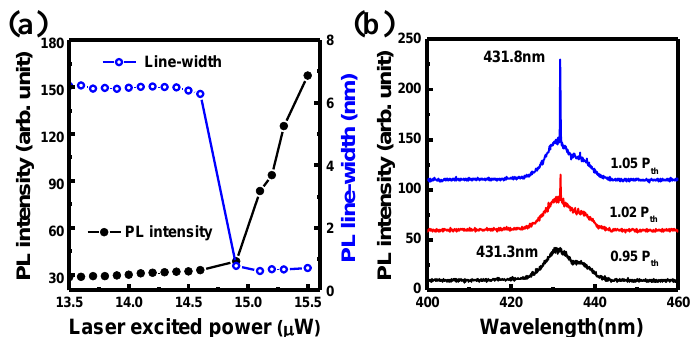
Figure 4. ( a ) The PL intensities and the linewidth of the optical pumping spectra were measured as a function of the laser excited power. ( b ) The emission spectra of the RC-LED structure were observed under 0.95 P th , 1.02 P th , and 1.05 P th laser pumping power.